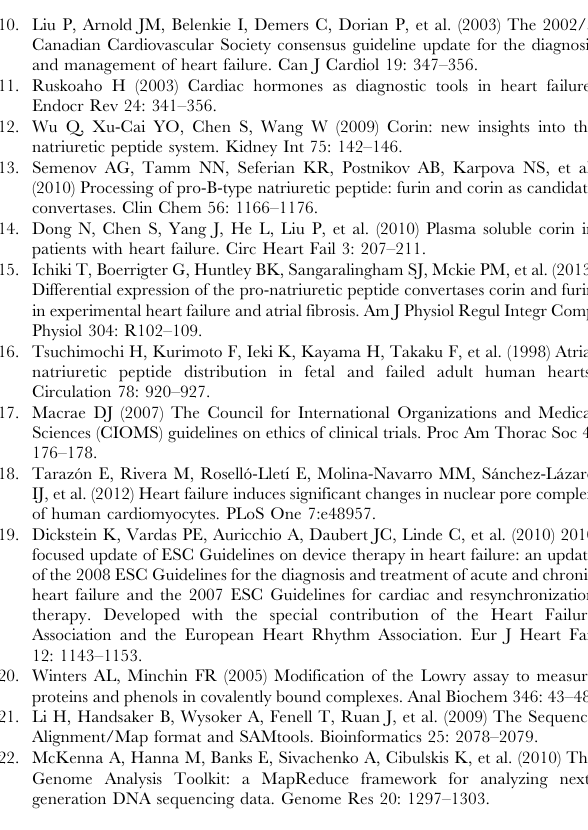
Figure S2 Correlation of endoproteases. The scatter plots showed the correlations of furin and corin in dilated cardiomy- opathy (A) and ischemic cardiomyopathy (B). Values were normalized to GAPDH and finally to the CNT group. (TIF) Figure S3 Correlation between atrial natriuretic pep- tide and corin in ischemic cardiomyopathy. Values were normalized to GAPDH and finally to the CNT group. (TIF) Figure S4 Correlation between corin and ejection fraction. Values were normalized to GAPDH and finally to the CNT group. (TIF) Table S1 Main statistical parameters of mapping step of analysis. (XLSX) Table S2 Percentage splicing reads of NPPA gene.